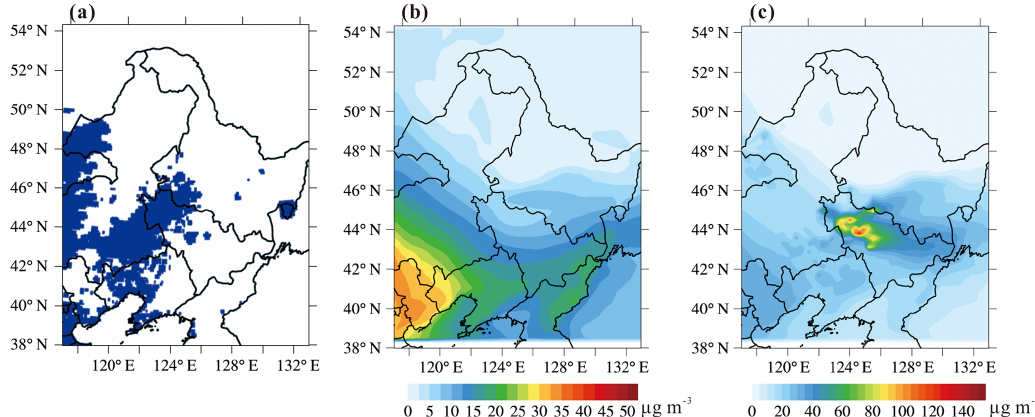
Figure 9. The substituted dust mask (a) and daily mean PM 10 distributions with (b) and without (c) the friction velocity limitation in NEC on 5 May 2015.